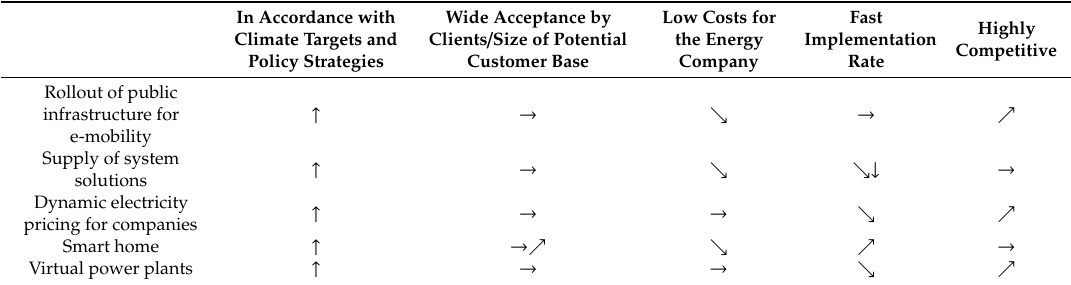
Table 9. Assessment of all business models—an